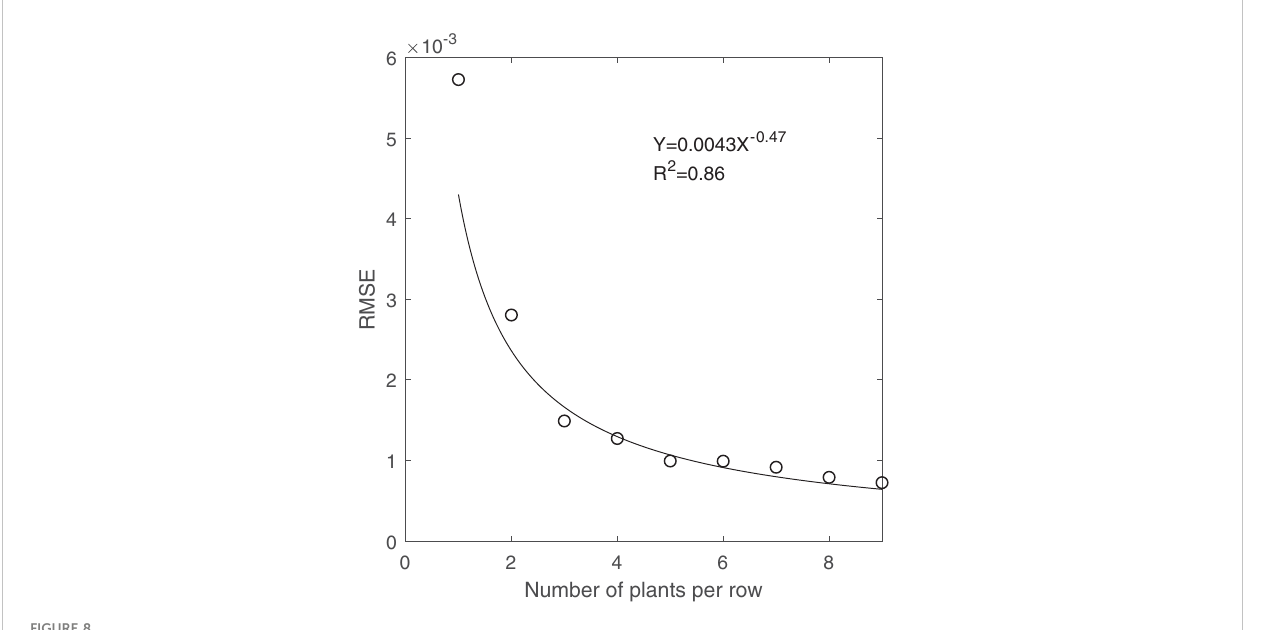
FIGURE 8 The correlation between areas containing the different number of plants per row and RMSE.